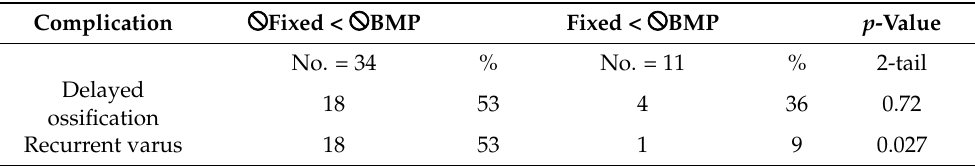
Table 4. Comparison of complications in primary SH: non-fixed angle + no BMP2 (group 1) vs. fixed angle + BMP2 (group 3).